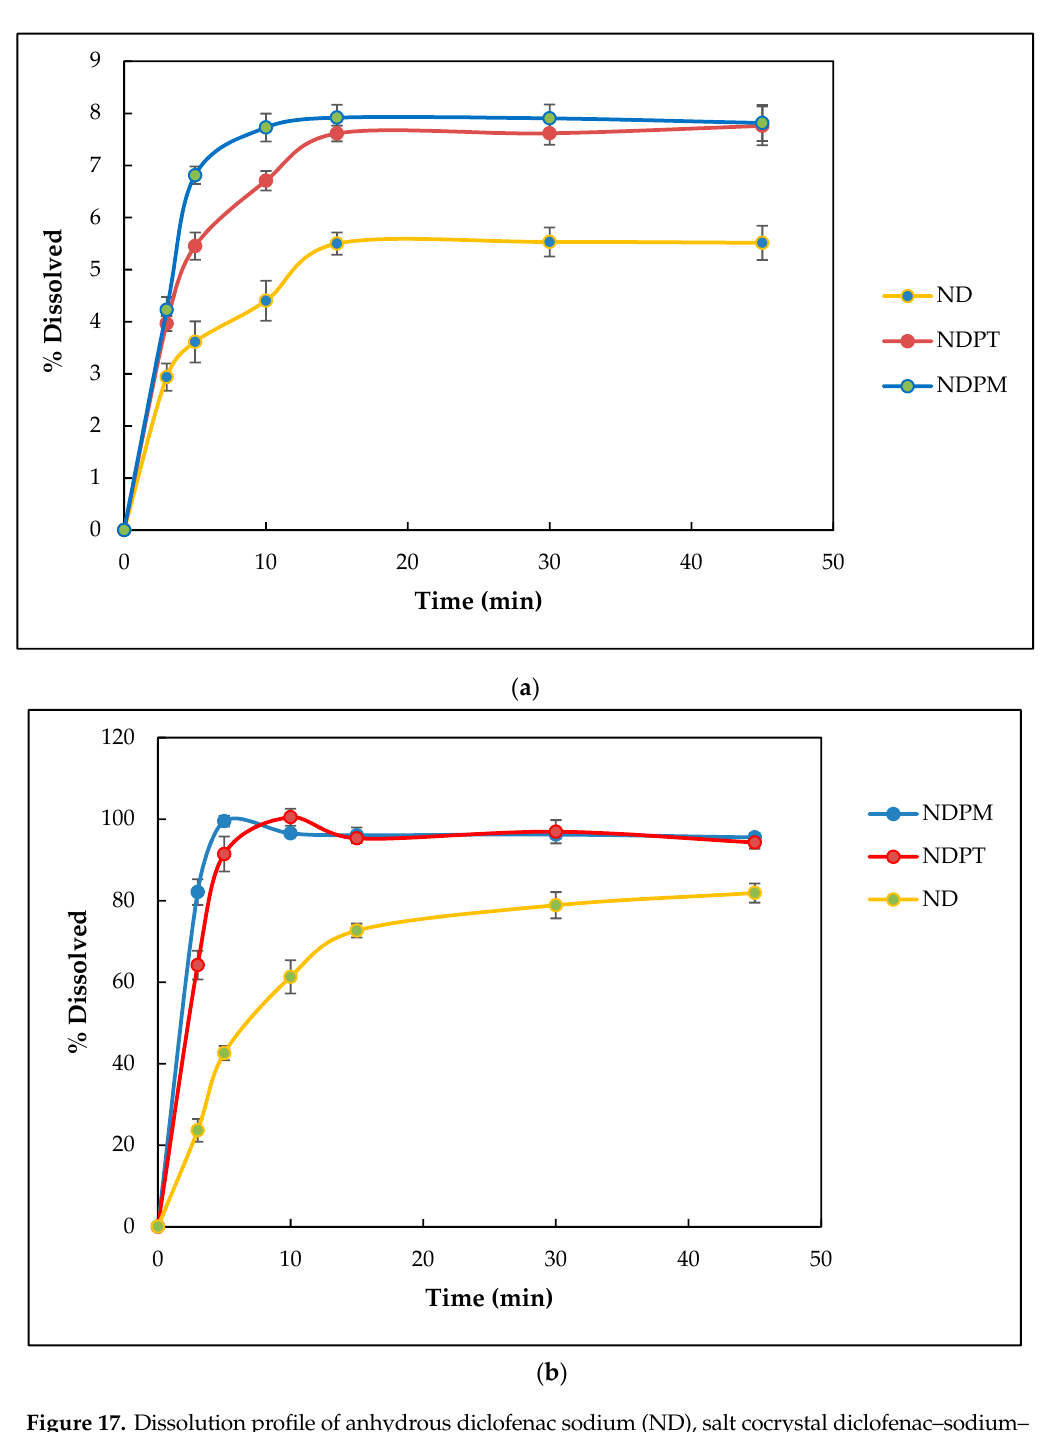
Figure 17. Dissolution profile of anhydrous diclofenac sodium (ND), salt cocrystal diclofenac–sodium–proline–monohydrate (NDPM), and salt cocrystal diclofenac–sodium–proline–tetrahydrate (NDPT) in ( a ) gastric pH (1.2) medium and ( b ) intestinal pH (6.8) medium.